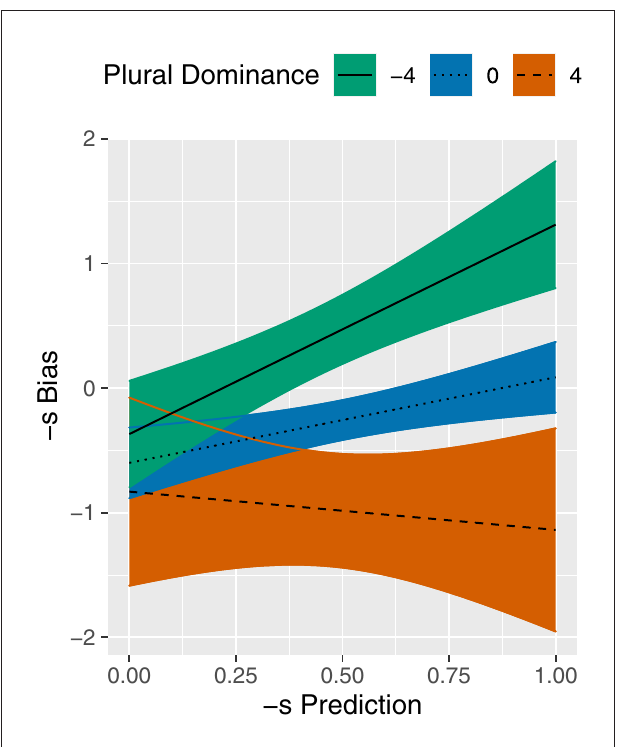
FIGURE 2 | Partial effect plot for the -S PREDICTION × PLURAL FREQUENCY interaction in the model of -S BIAS . PLURAL DOMINANCE is held constant at the median value. Coloured bands reflect 95% confidence